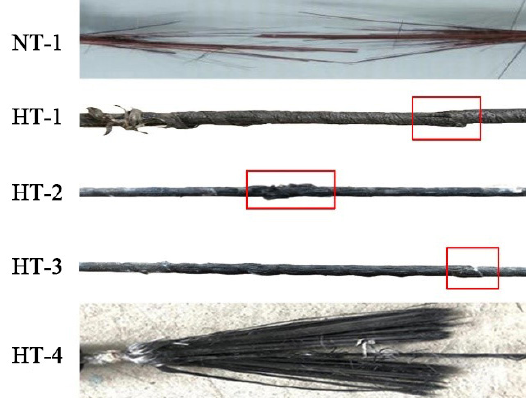
Figure 5. Failure mode of CFRP tendons under various test conditions.